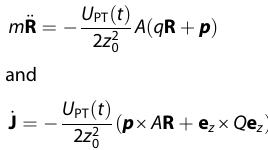
pattern by about 2 π /5 (dashed